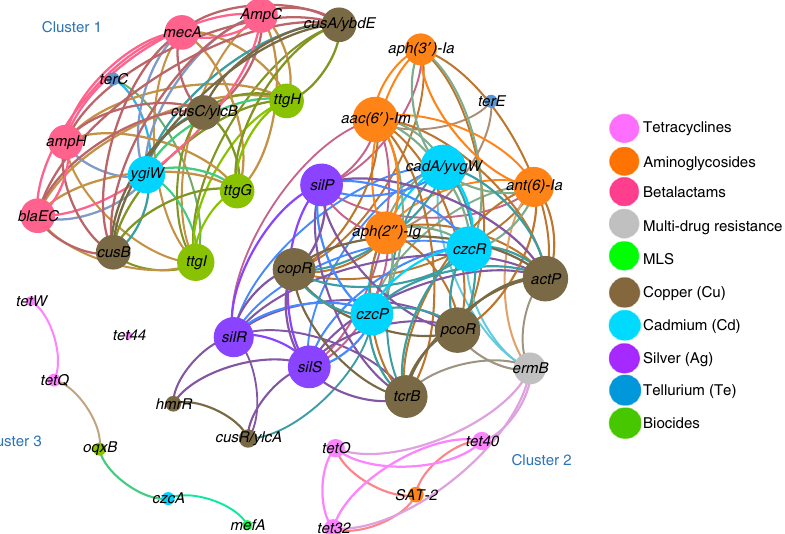
Fig. 8 The co-occurrence networks among ARGs and BMRGs in dairy calves. The nodes (resistance genes) were colored by corresponding class of antibiotics, metal or biocide compounds, and the size of each node represented the number of connections (degree)